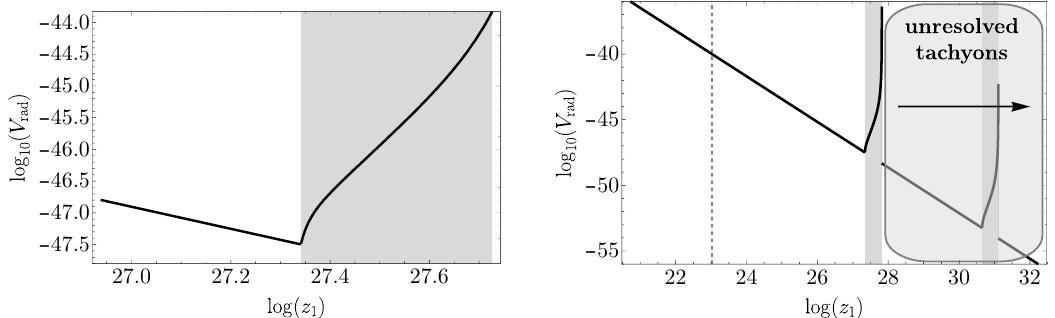
Figure 2. Here we display the radion potential, V rad ( z 1 ). In the white region, the Higgs VEV is vanishing, and the radion potential is a pure quartic. In the gray region, (cid:30) ( z 1 ) 6 = 0, and the contribution of the Higgs to the radion potential causes a kink-like minimum to appear at the critical points. In the (cid:12)rst plot, we have zoomed in on the (cid:12)rst minimum, corresponding to the smallest z 1 for which the criticality conditions are met. In the second plot, we zoom out, showing other potential minima. These are unhealthy, in that the theory at this point contains unresolved tachyons. The dashed vertical line in the second plot corresponds to the value of z at which the evolving bulk Higgs mass passes the BF